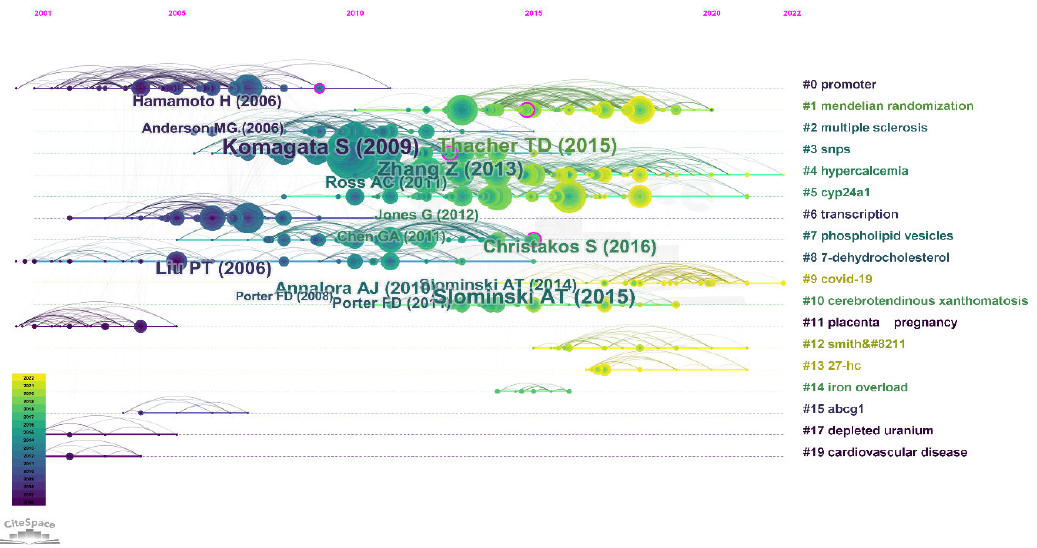
Figure 4. Timeline analysis co-citation network showing 19 clusters of changes in authors’ keywords over time, lighter colors indicate recent co-citation relationship. The topic of each cluster is shown on the right side of the image. A larger nodes label indicates higher centrality, starting from Komagata S (2009, cluster #0 [50]) and Slominski AT (2015, cluster #7 [51]) with 0.11 centrality, and Liu PT (2006, cluster #6 [52]), Thacher TD (2015, cluster #1 [53]) and Zhang Z (2013, cluster #3 [54]) with 0.1 centrality (marked with pink circle).